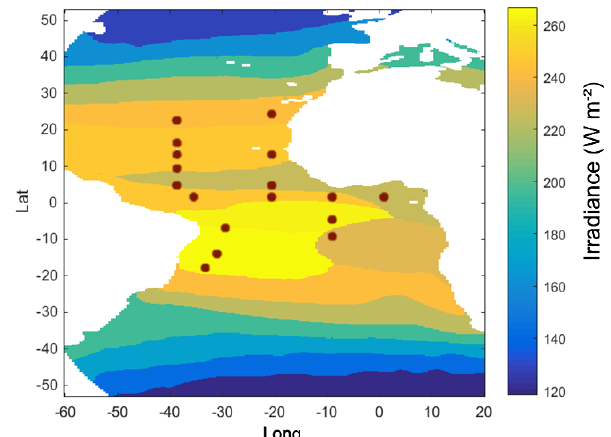
Figure 8. Location of the 17 buoys superimposed on the map of classes of DSIS. The colour indicates the mean yearly